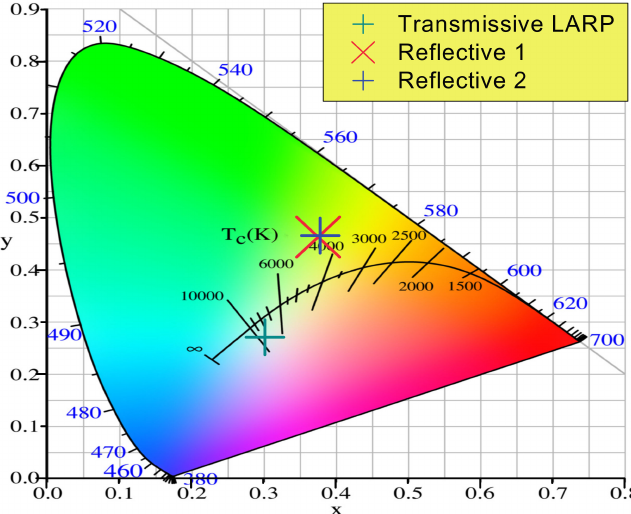
Figure 21. Chromatic properties of the beam emitted from the three LARP